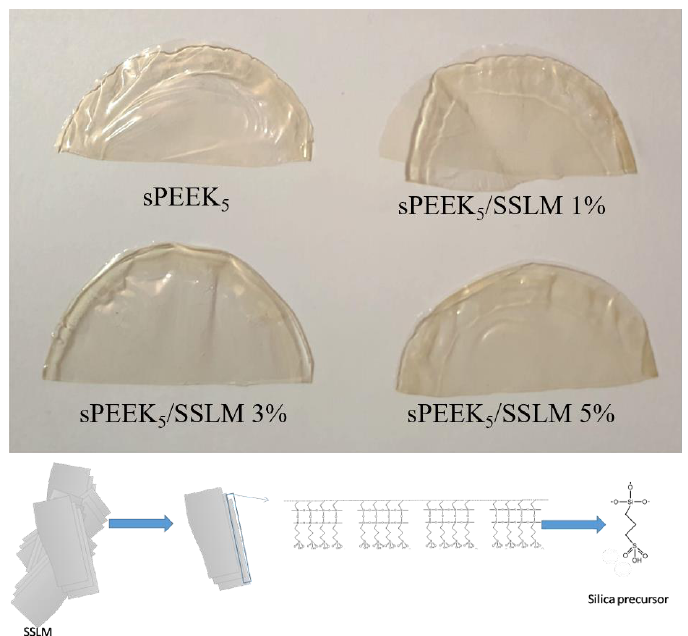
Figure 6. Pictures of the sPEEK 5 and sPEEK 5 / SSLM composite membranes. The molecular structure of the sulfonated SLM is also reported.